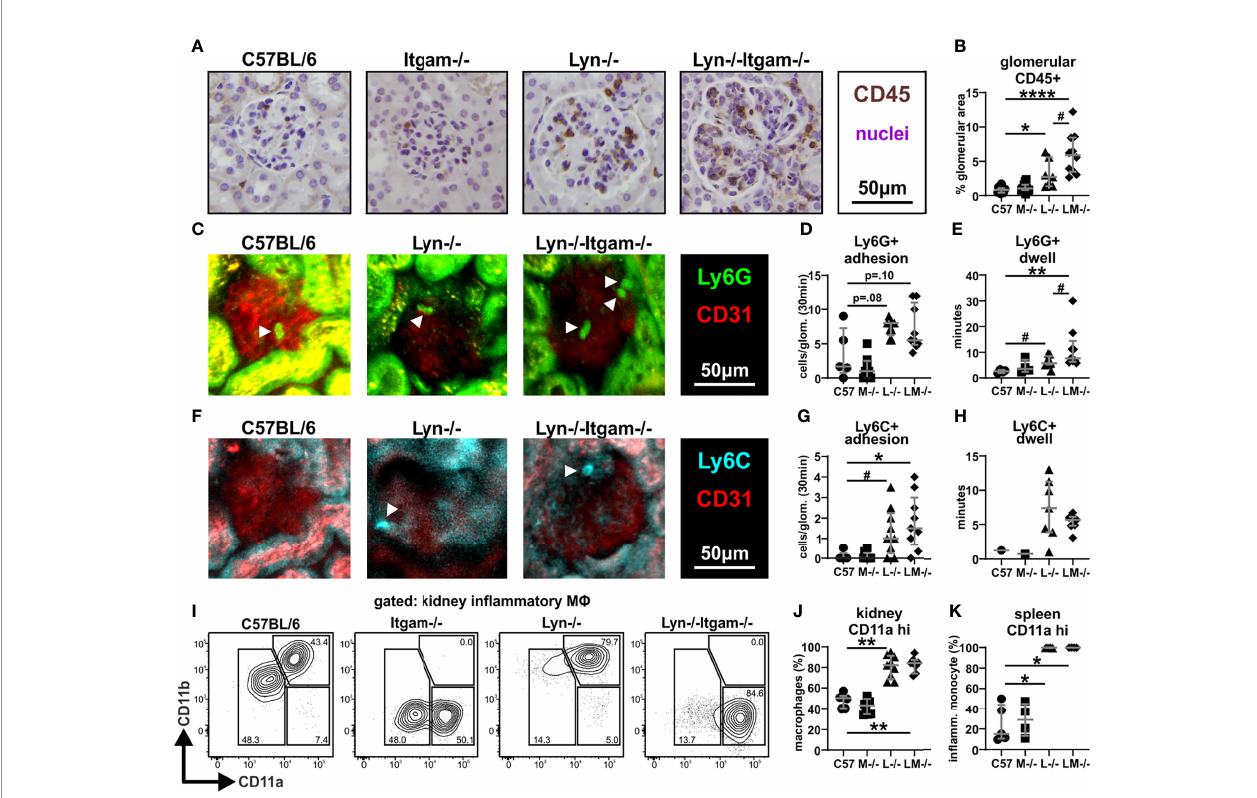
FIGURE 5 | Leukocyte traf fi cking to the kidney is not perturbed by de fi ciency of CD11b in Lyn -/- mice. (A) Kidneys from 24-week-old mice were assessed by immunohistochemistry for the presence of CD45+ cells with (B) quantitation of CD45+ staining within the glomeruli. Two-photon live fl uorescence imaging of the glomerular vasculature of 24-week-old mice depicting (C) Ly6G+ labelled neutrophils with quanti fi cation of (D) neutrophil adhesion (number of cells adhering to the vascular endothelium within a 30-minute window per glomerulus) and (E) Ly6G+ neutrophil dwell time (average length of time each detected cell remains adhered to the vascular endothelium). Two-photon live fl uorescence imaging of the glomerular vasculature depicting (F) Ly6C+ labelled migratory monocytes with quanti fi cation of (G) migratory monocyte adhesion and (H) monocyte dwell time. (I) Flow cytometric assessment of the expression of integrin CD11a (LFA-1) on kidney Ly6C+ in fl ammatory macrophages with (J) quanti fi cation and (K) quanti fi cation of CD11a expression on splenic Ly6C+ migratory monocytes. Images in (A, C, F) are representative of 3-5 experiments, white arrowheads indicate intravascular Ly6G+ or Ly6C+ cells. Data in (B) represent n = 7-12 per group and data in (D, E, G, H) are of n = 5-9 per group. Flow plots in (I) are representative of two experiments, data in (J) are of n = 5-9 per group and data in (K) are of n = 4-5 per group, both pooled from two experiments. *p < 0.05, **p < 0.01, ****p < 0.0001 by Dunn ’ s multiple comparisons test and p value stated if approaching signi fi cance (p < 0.1), # p < 0.05, by Mann-Whitney U